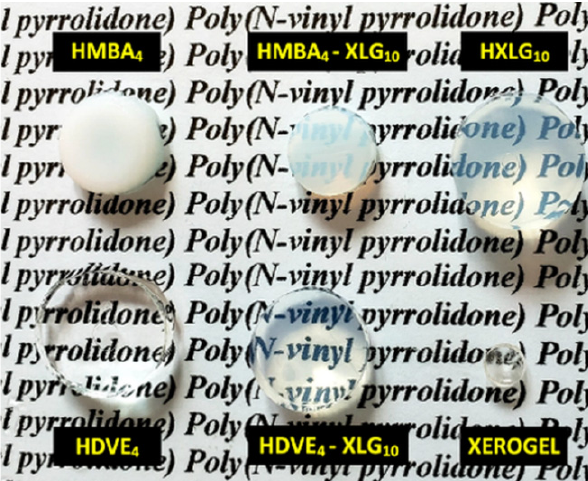
Figure 2. Appearance of the equilibrium-swelled hydrogels.